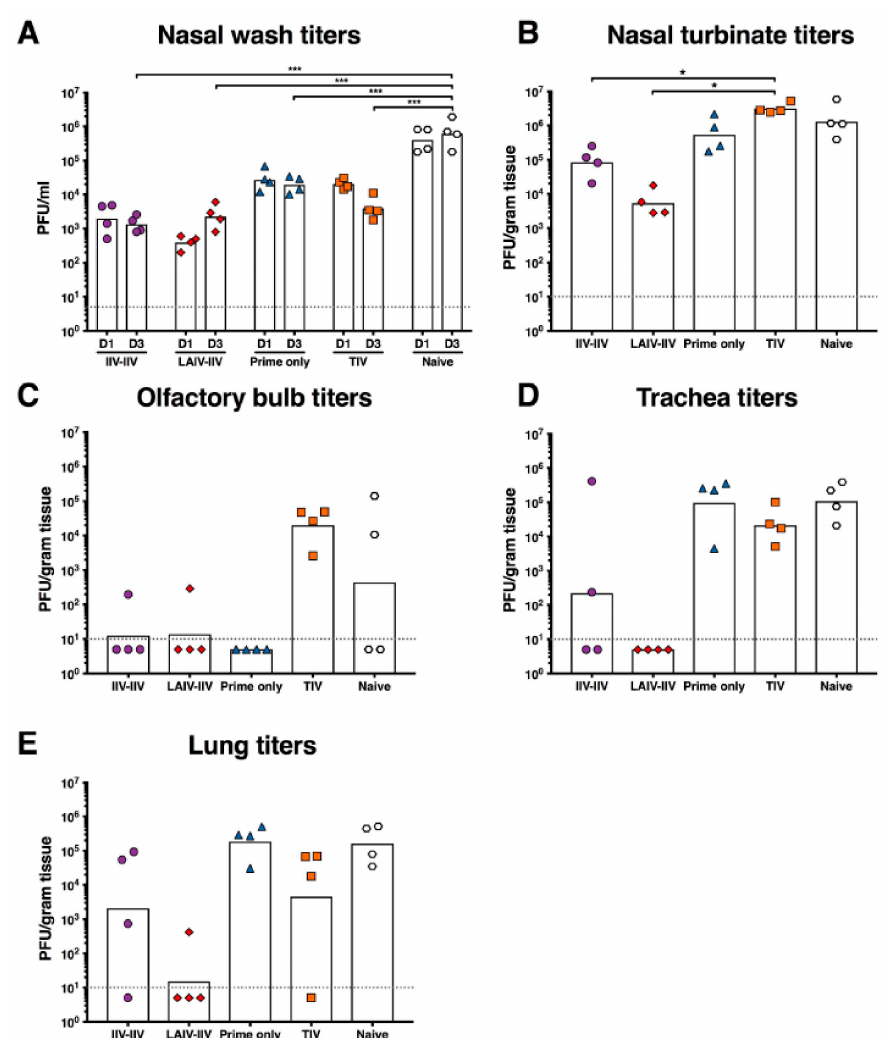
Figure 4. Viral titers after pandemic H1N1 challenge. Viral titers were measured in nasal wash titers ( A ) on days 1 and 3 post-challenge. After euthanizing the ferrets on day 4 post-challenge, viral titers were measured in the nasal turbinates ( B ), olfactory bulbs ( C ), tracheas ( D ), and lungs ( E ). The IIV-IIV group is shown as purple circles, the LAIV-IIV group is shown as red diamonds, the prime only group is shown as blue triangles, the TIV group is shown as orange squares, and the naïve (unvaccinated) control group is shown as white hexagons. Each point indicates an individual animal. The statistical significance between groups is indicated by asterisks (* p ≤ 0.05; *** p ≤